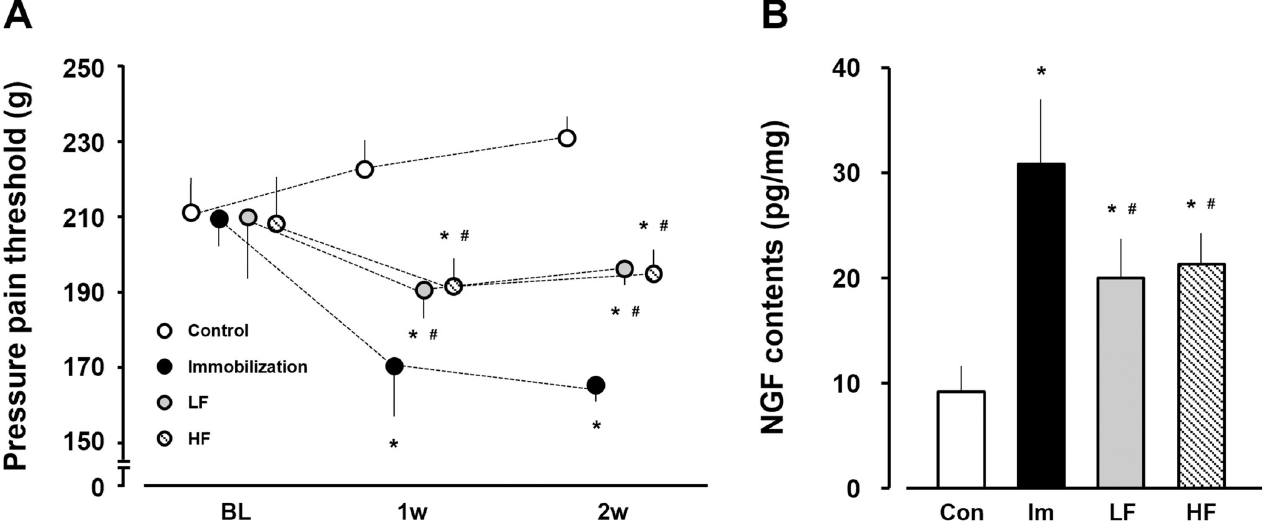
Fig 7. Pressure pain threshold (A) and NGF content (B) in gastrocnemius muscle. Open circles and bars, control group (control). Black circles and bars, immobilization group (Im). Gray circles and bars, LF group. Hatched circles and bars, HF group. Data are presented as mean ± standard deviation. � Significant difference (p < 0.05) compared to the control group #Significant difference (p < 0.05) compared to the immobilization group. NGF, nerve growth factor; LF, low-frequency; HF,